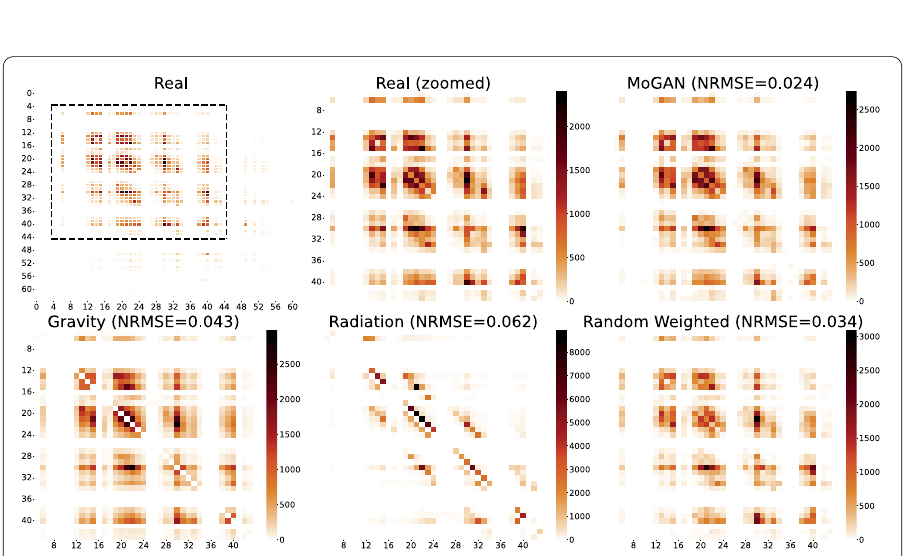
Figure 7 Visual comparison of the adjacency matrices of the Mobility Networks. Visualization of the more dense part of the mobility networks of NYC Bikes having the maximum sum of flows observed in the Test Set (Real Zoomed) and of the Mobility Networks having the maximum sum of flows observed in the fake sets produced by all of the other models. Per each generated matrix, we reported the RMSE with respect to the Real matrix. In the top left panel, we show the full 64 × 64 mobility network and highlight the most dense zones, on which we focus in the other plots of the